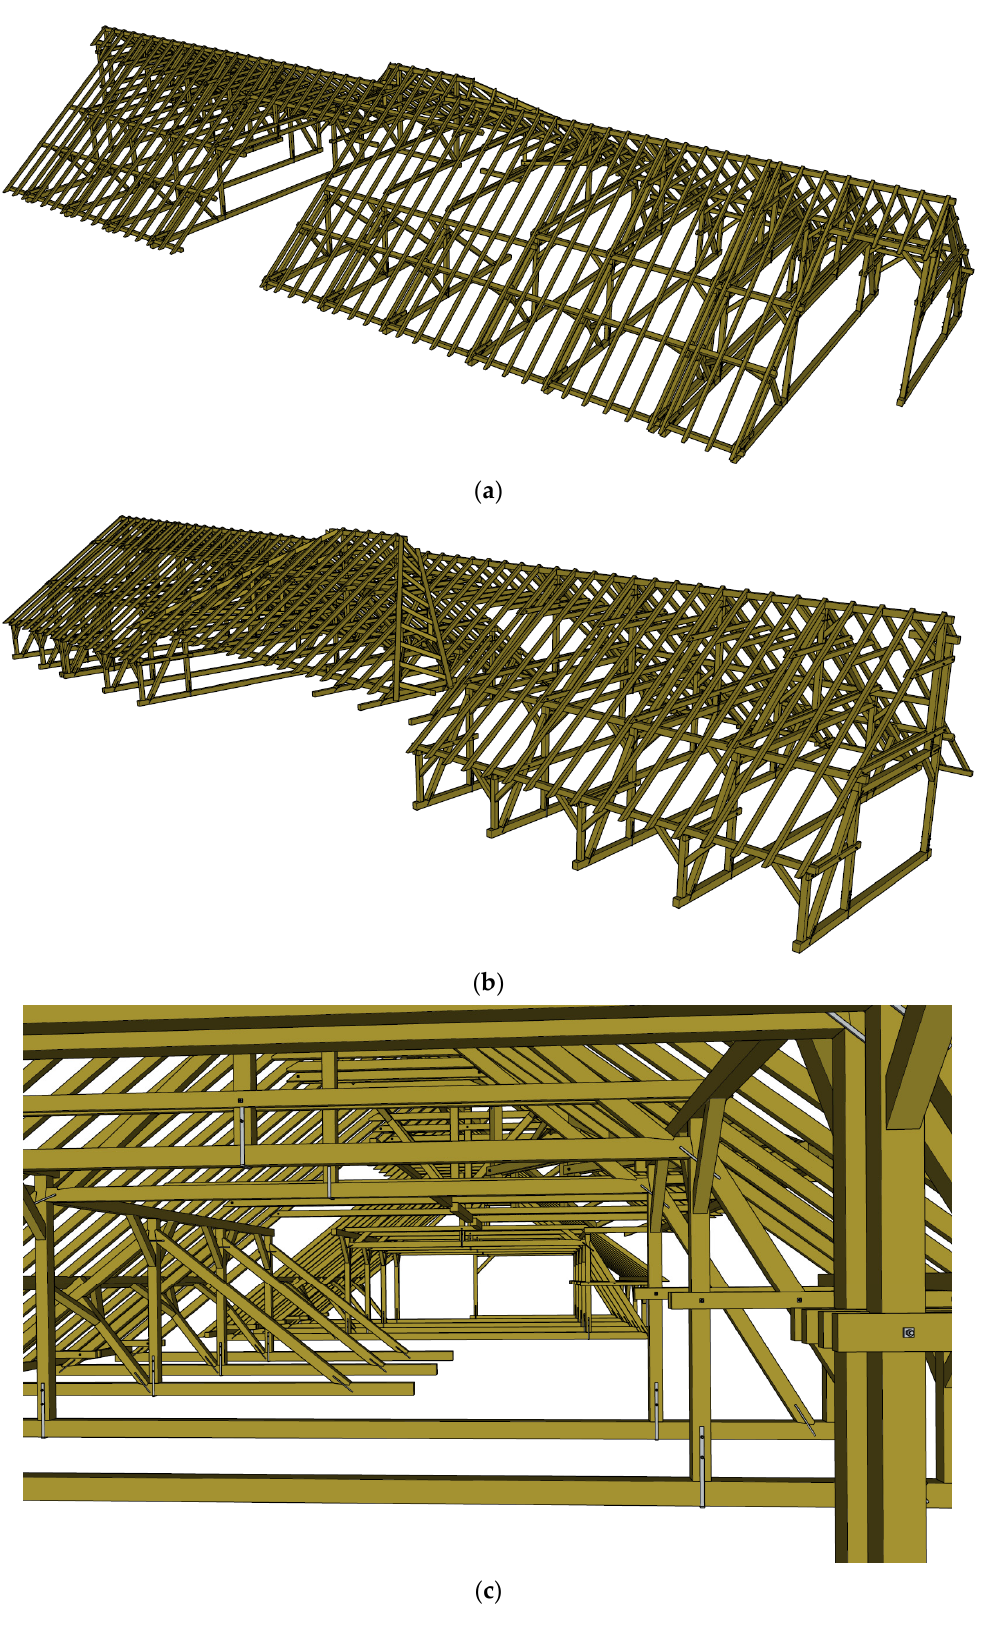
Figure 13. A 3D model of roof timber structures: ( a ) northside view; ( b ) southside view; ( c ) view from the inside.